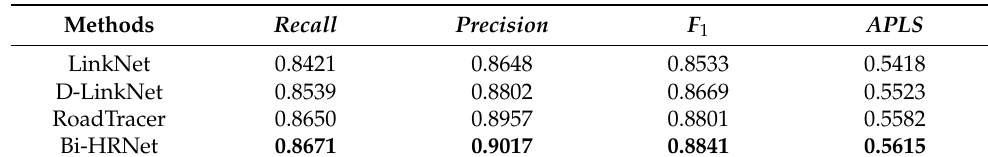
Table 3. Quantitative results of the proposed method and compared methods on the constructed Google dataset.